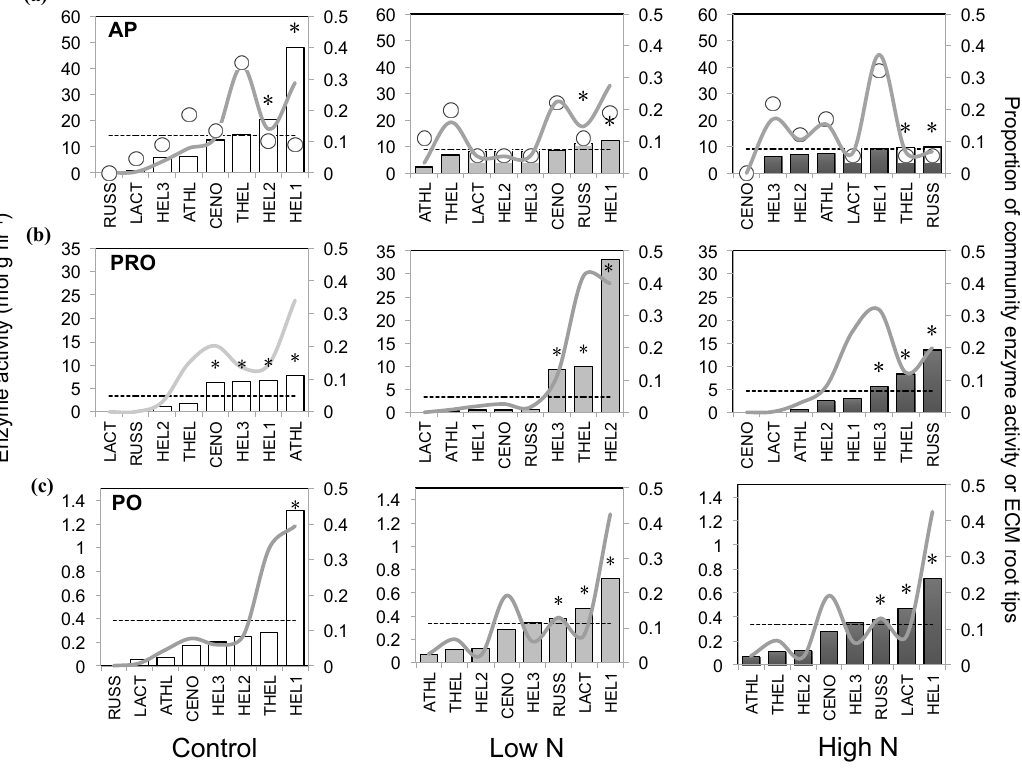
Figure 3. Levels of ectomycorrhizal (ECM) root tip relative abundance (open dot) and the relative contribution (grey curve) of individual ECM group to overall ECM community activity of ( a ) acid phosphatase (AP), ( b ) protease (PRO), and ( c ) phenol oxidase (PO) in response to N fertilization. Within each panel for enzyme and N fertilization treatment, broken lines within each panel indicate the mean community level of enzyme activity. Columns denoted with an asterisk (*) denote ECM species in which enzyme activity was significantly greater ( p < 0.05) than the mean community value.